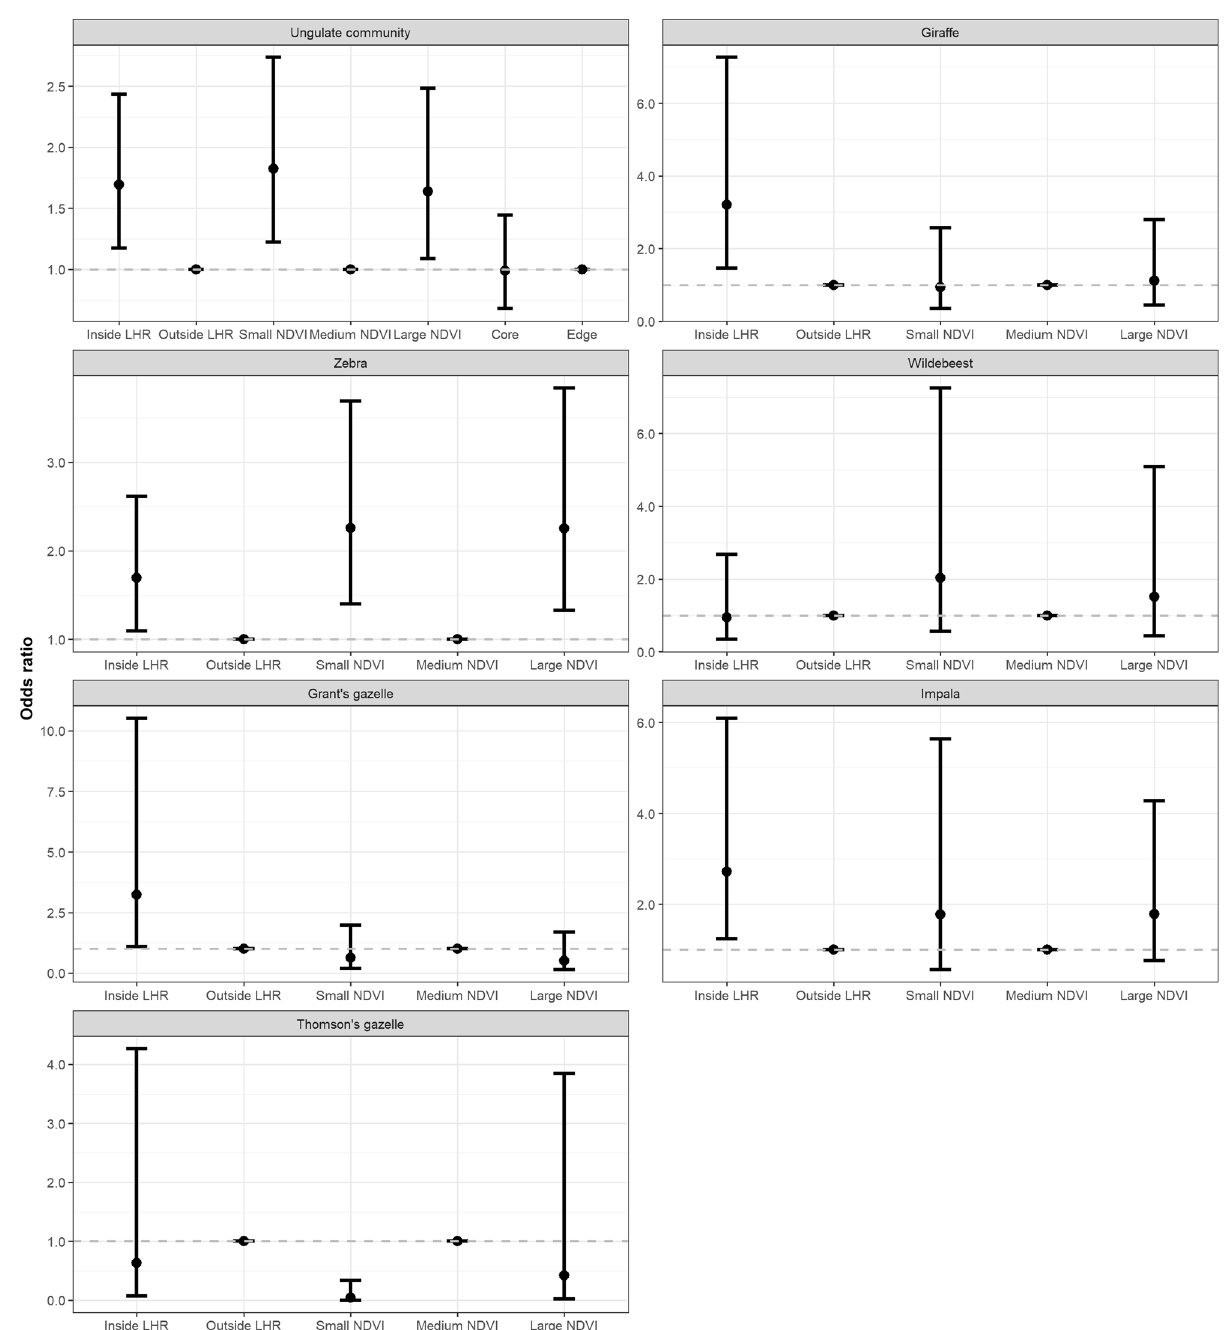
Figure 2. Odds ratios depicting the relative effects of primary productivity (indicated by small and large NDVI values relative to medium NDVI values) and predation risk (indicated by location of the observation inside vs. outside the lion home range [LHR]) on the likelihood of mixed species group occurrence in the entire ungulate community and separately for six species within Manyara Ranch, northern